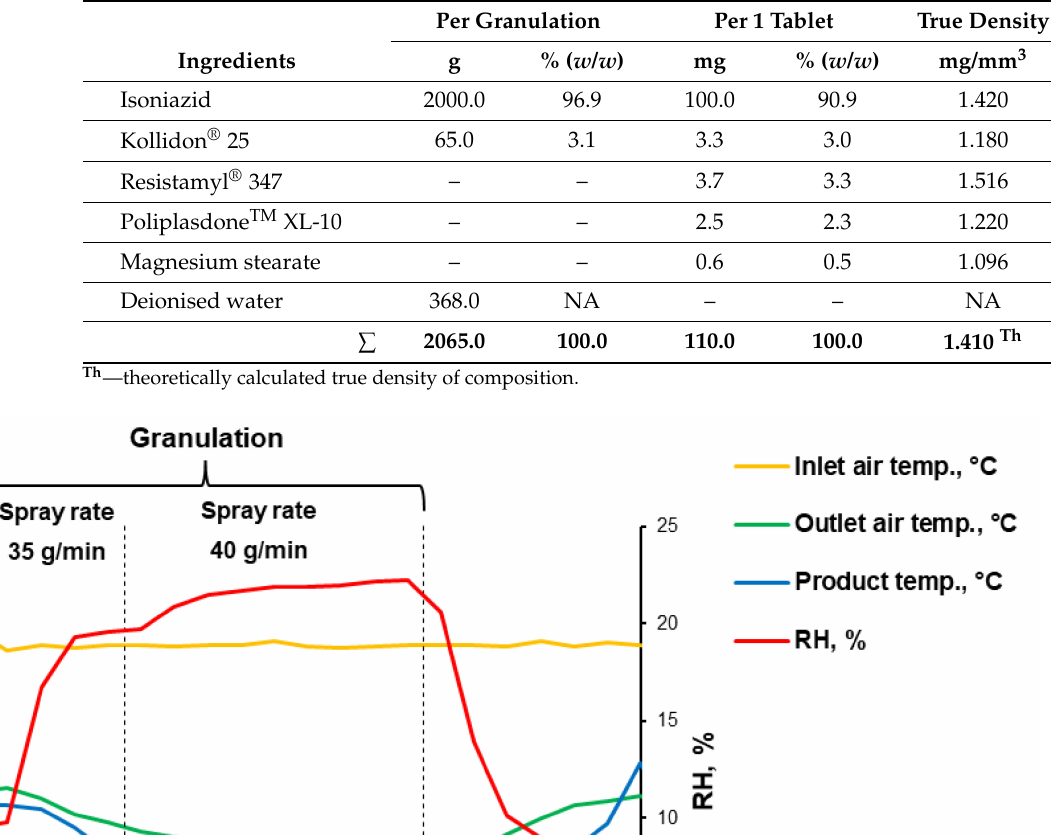
Table 1. Granulate and tablet composition.